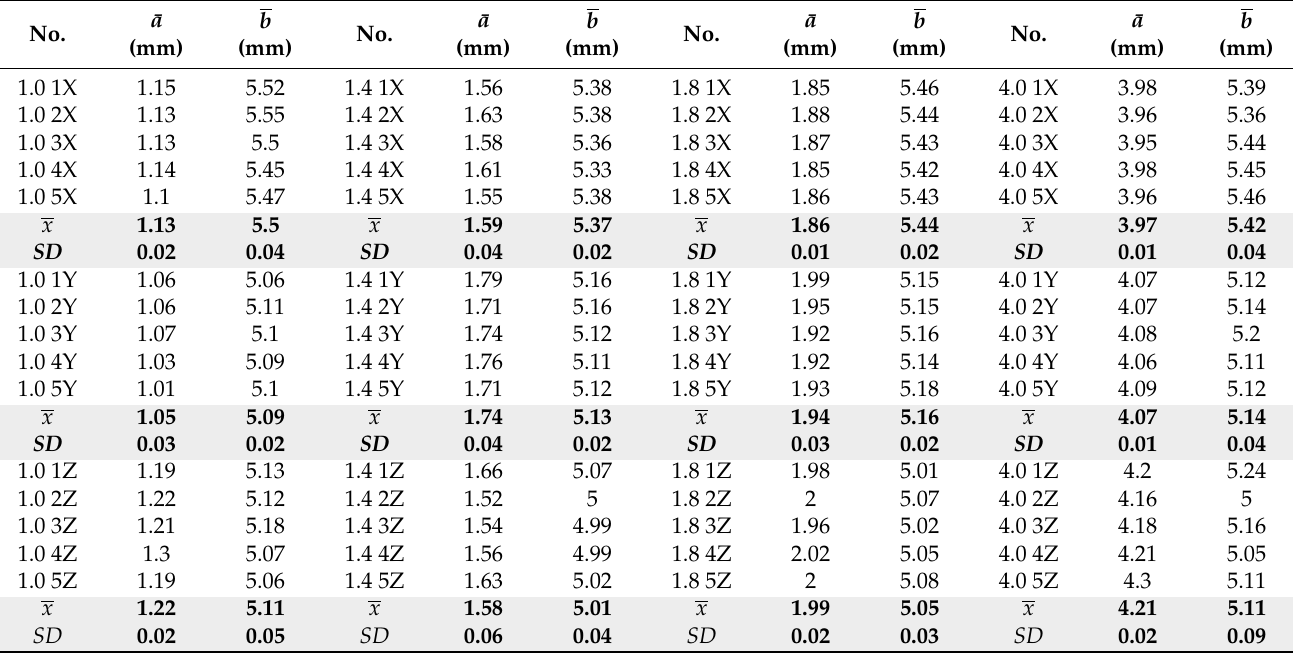
Table 2. Dimensions of the PLA prints before the tensile